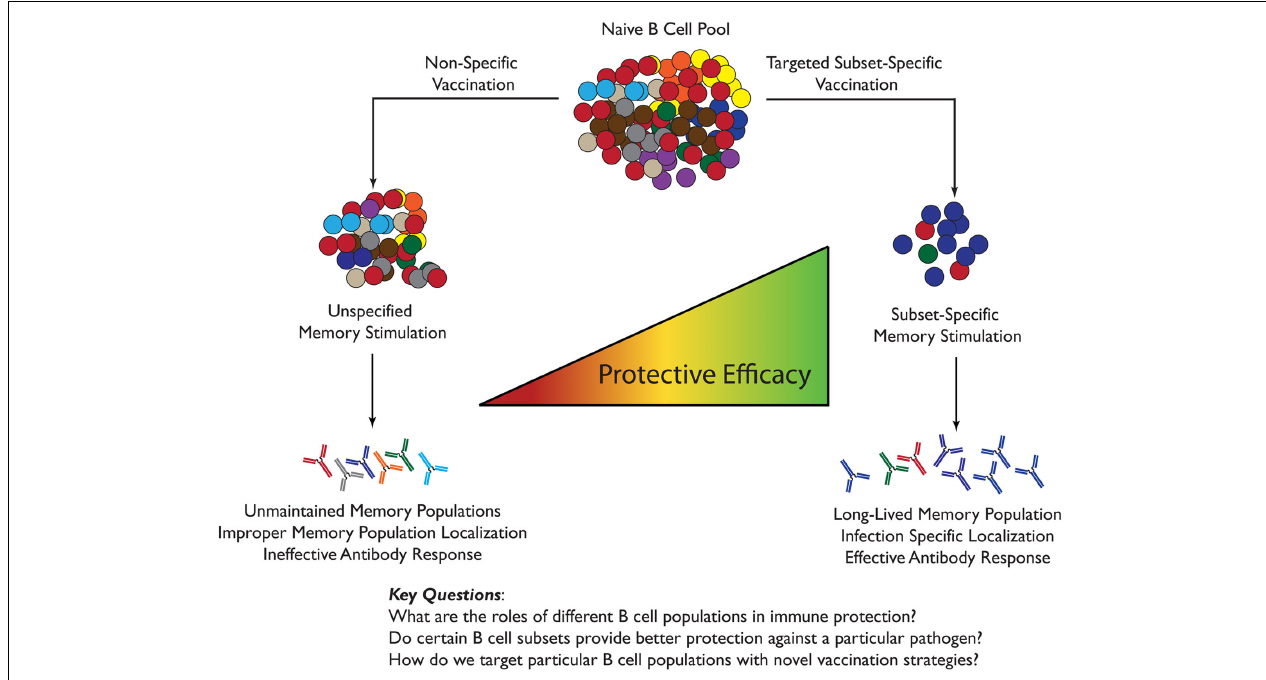
vaccine the localization, type and magnitude of antibody response, and the maintenance of the memory B cell subset populations can be altered to generate an effective antibody response upon subsequent exposure. Conversely, non-specific memory B cell vaccine design can lead to the loss of maintenance and/or establishment of important memory populations, improper response localization, and ineffective antibody response.These factors combined can lead to a loss of efficacy in a